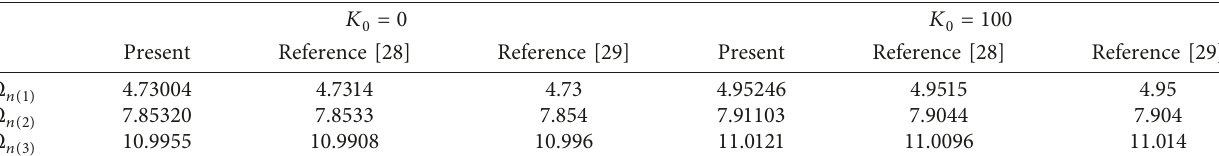
Table 3: Natural frequencies of the clamped-clamped beam on an elastic foundation with P � 0 and without the nonlinear term.